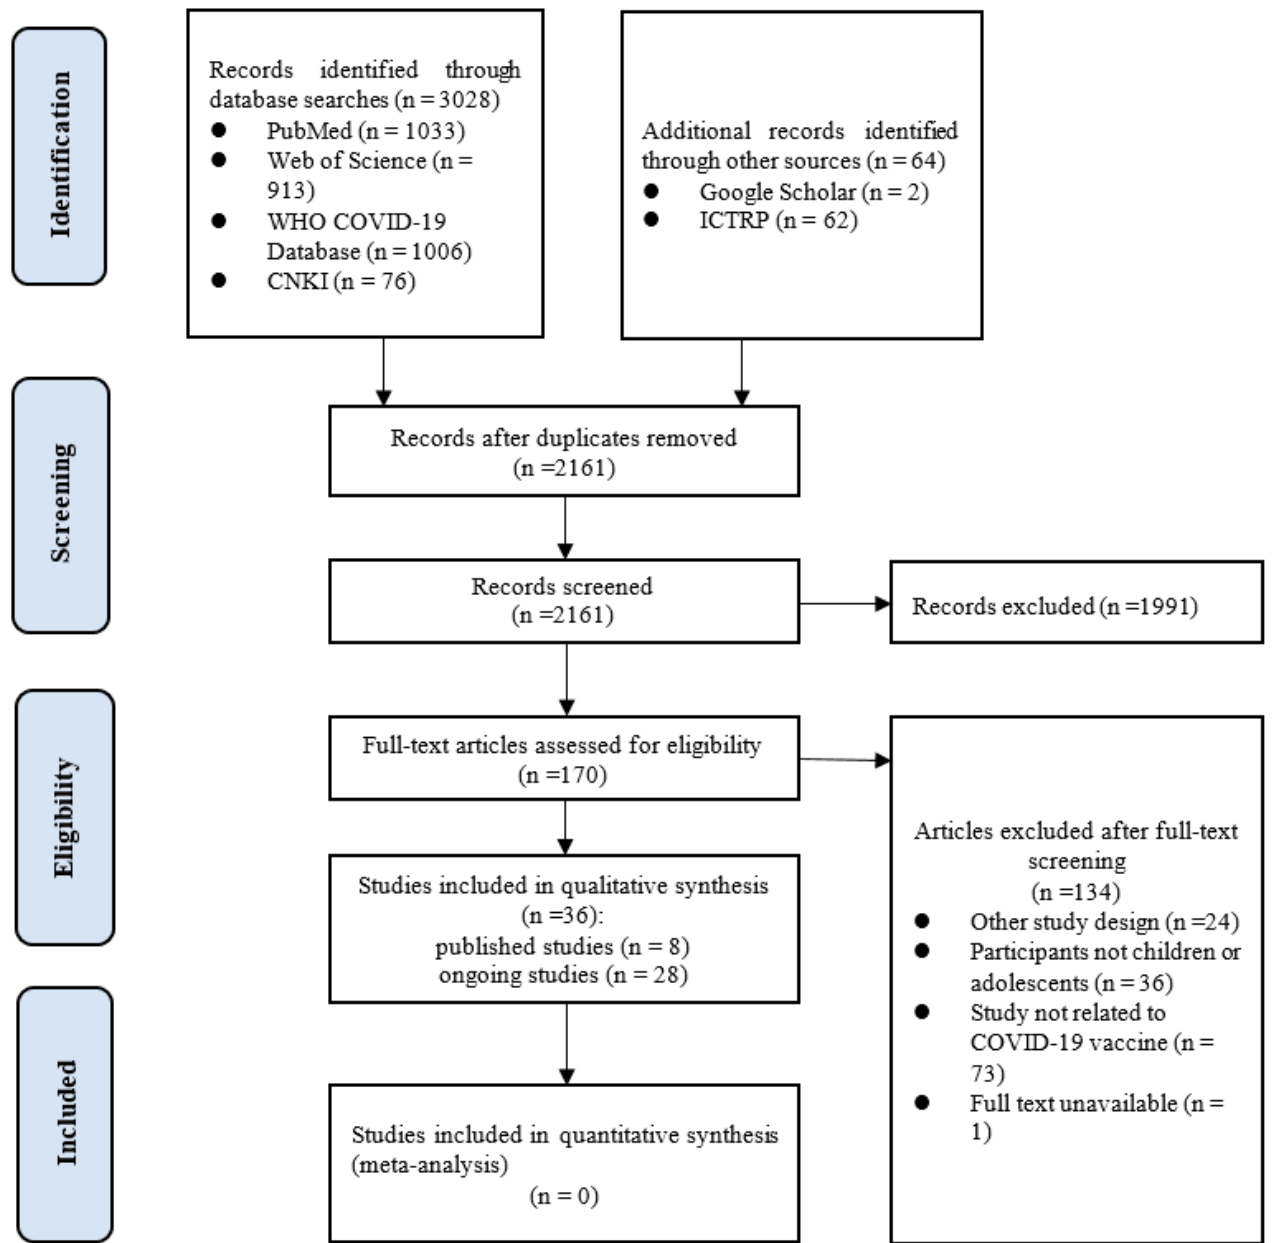
Figure 1. Study selection process (WHO: World Health Organization; COVID-19: coronavirus disease 2019; CNKI: China National Knowledge Infrastructure; ICTRP: International Clinical Trials Registry